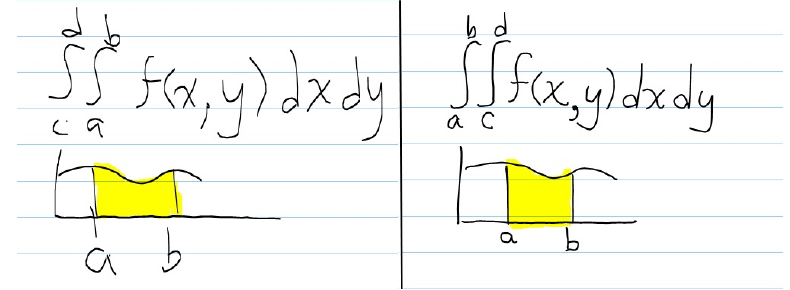
Figure 4: Passive Stylus on the Left, Active Digitizing Stylus on the